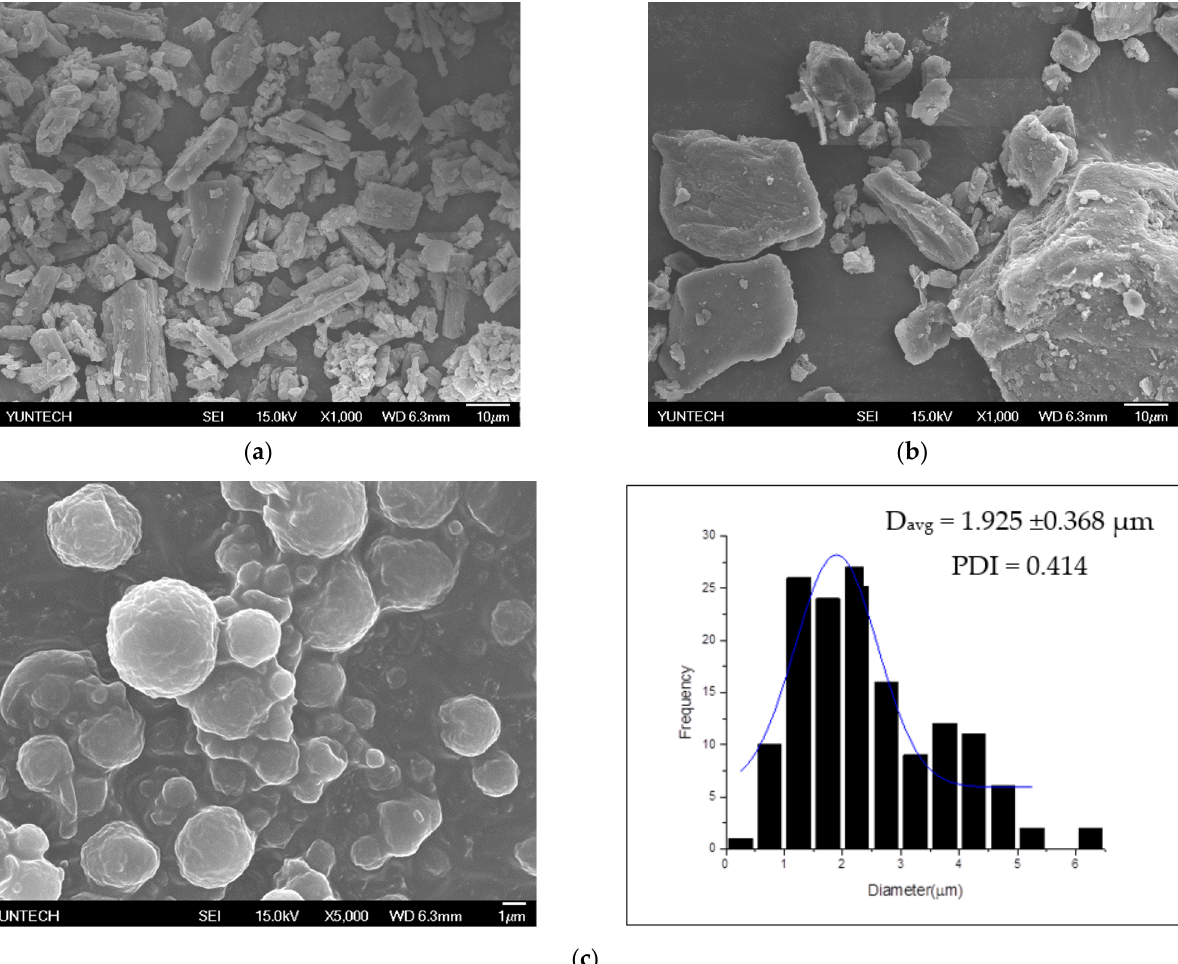
jelly fig pectin as a matrix by in situ crosslinking increased the encapsulation